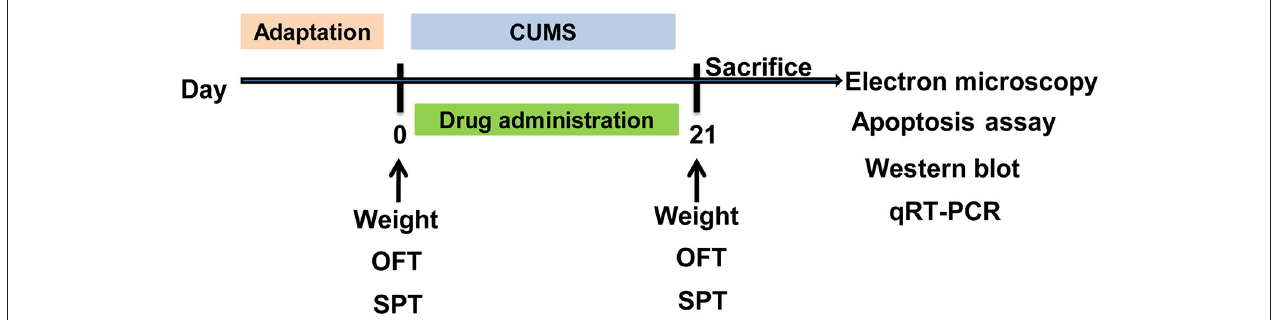
FIGURE 1 | Schematic diagram of the timeline for CUMS, drug treatment and behavioral testing schedule. CUMS, chronic unpredictable mild stress; SPT, sucrose preference test; OFT, open field test. The rats were sacrificed on the 21st day.